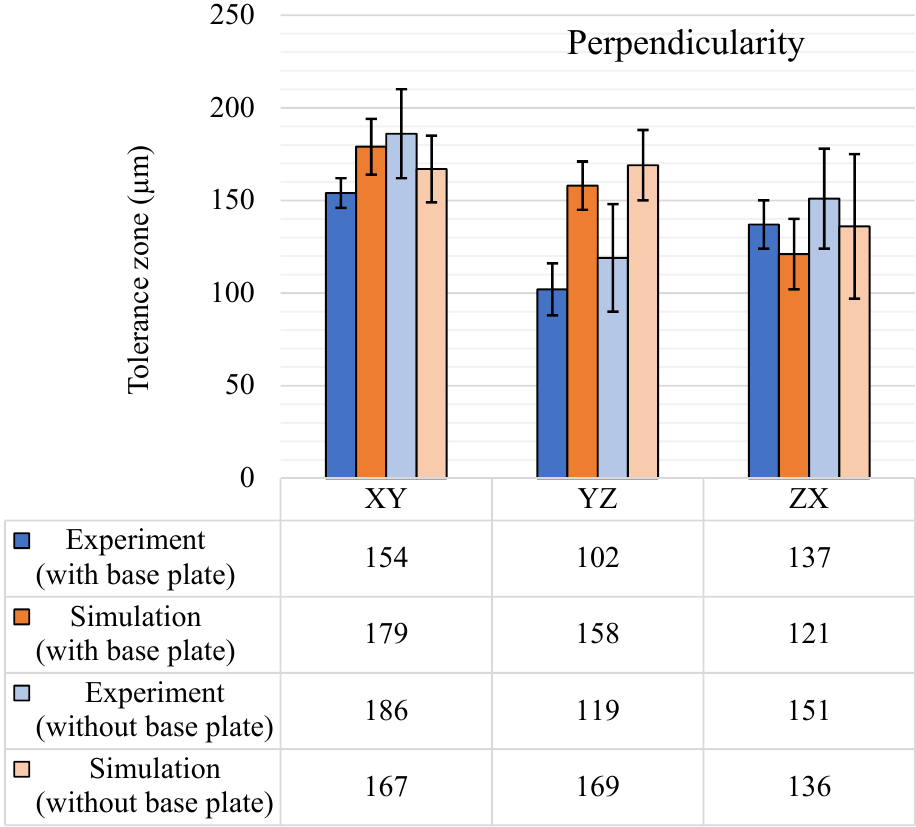
Figure 13. Perpendicularity ( µ m) tolerance results, with and without the base plate.